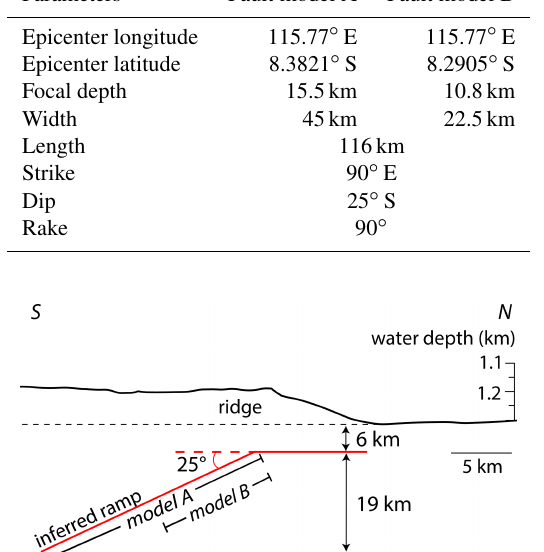
Figure 3. Profile of the fault geometry used in the tsunami modeling relative to the seafloor ridge. We study two fault slip models: model A (whole-ramp rupture) and model B (slip only on the upper half of the ramp). The location of the profile is shown in Fig.